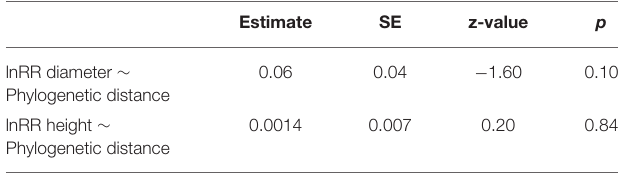
TABLE 2 | Test for phylogenetic Janzen-Connell effects on plant-soil feedbacks (lnRR) ( Figure 3